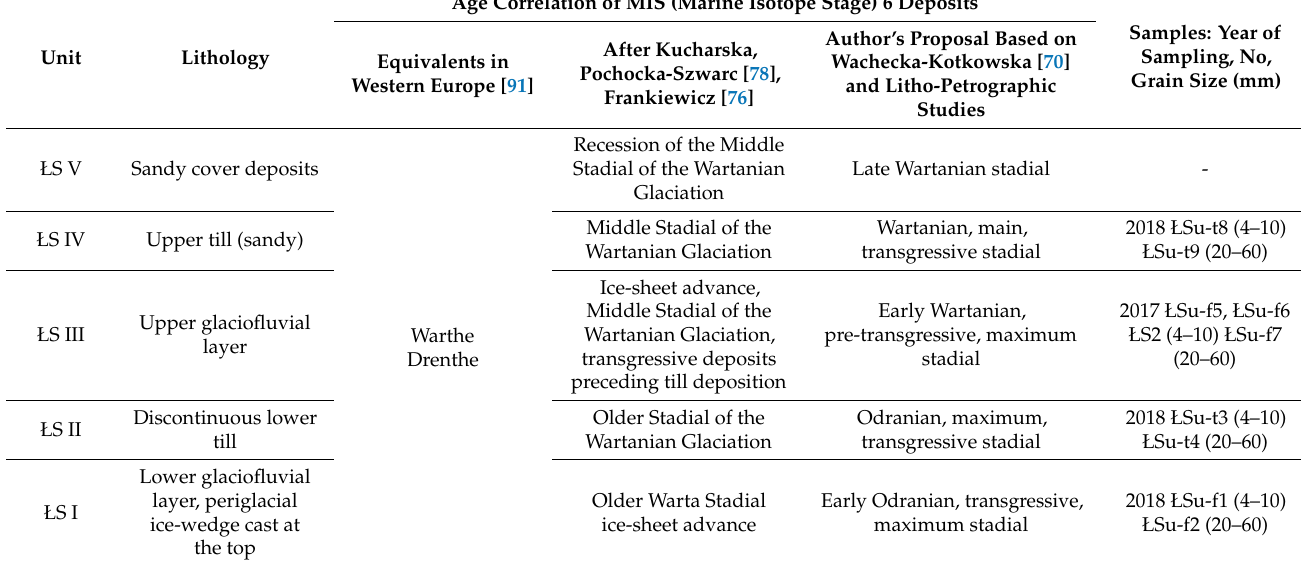
Table 1. Lithostratigraphical situation of the sediments in the Łubienica-Superunki gravel pit (2018) and the types of samples taken for petrographic